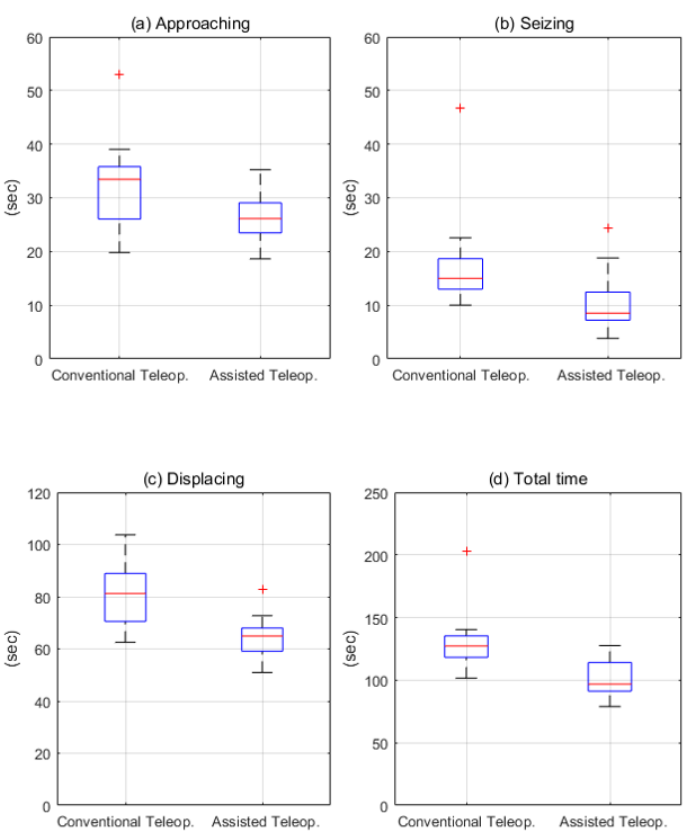
Figure 12. Box plots of experimental time taken for each step: ( a ) approaching step, ( b ) seizing step, ( c ) displacing step, ( d ) total time for all steps. Table 3. Experimental results: averaged time and p -value. Approaching Seizing Displacing